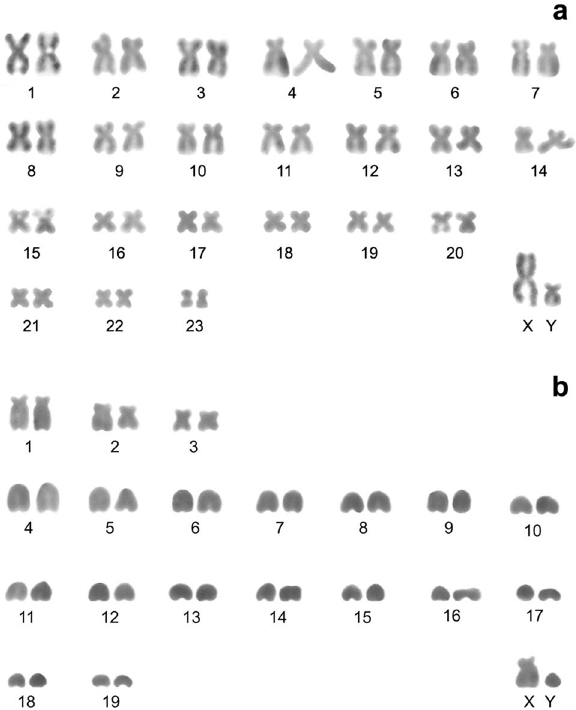
Figure 6. Conventionally stained male karyotypes. ( a ) Anourosorex squamipes from Gansu Province (Zhuoni), 2n = 48, NF a = 92; ( b ) Crocidura suaveolens from Sichuan Province (Zoige city), 2n = 40, NF a = 44. XY: sex chromosomes.